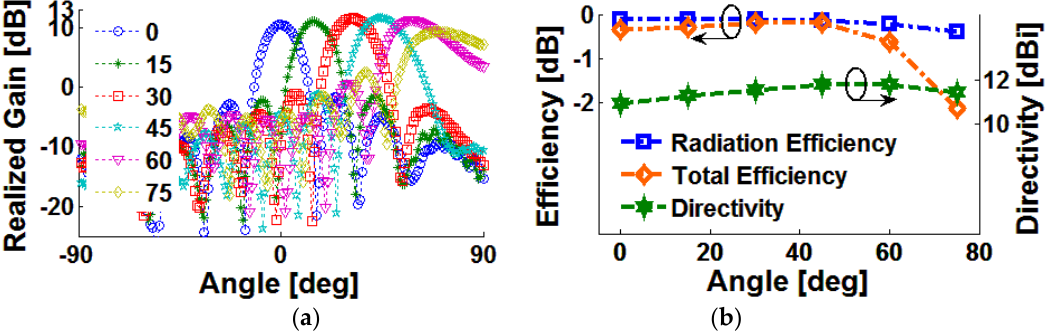
Figure 16. ( a ) Realized gain (Cartesian), ( b ) efficiency and directivity properties at different angles.